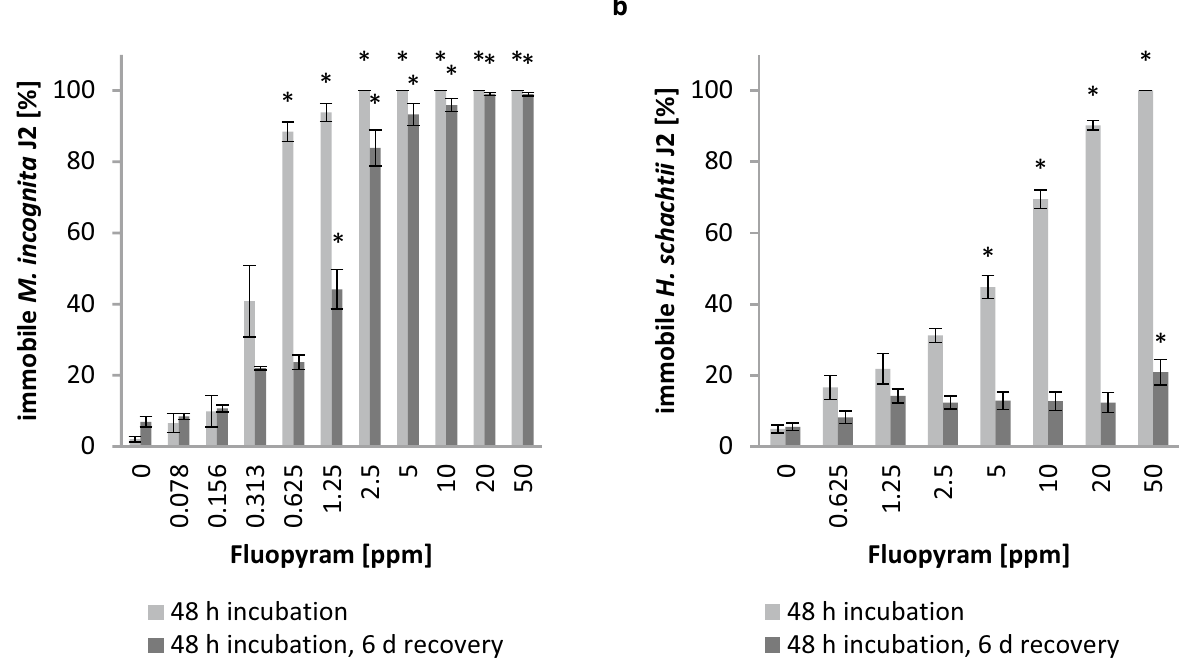
Figure 1. Fluopyram is lethal for Meloidogyne incognita but not for Heterodera schachtii . M. incognita J2 ( a ) and H. schachtii J2 ( b ) were exposed to different concentrations of fluopyram or DMSO control for 48 h. Subsequently, nematodes were washed and incubated in water for further 6 days. The number of immobile nematodes (without ( a ) or with NaOH stimulus ( b )) were counted at both of these time points. Values represented as mean ± SE of three independent biological replicates (n = 6–12 ( a ); n = 14–18 ( b )). Asterisks indicate significant differences to control according to Dunn’s method ( b ) ( p <